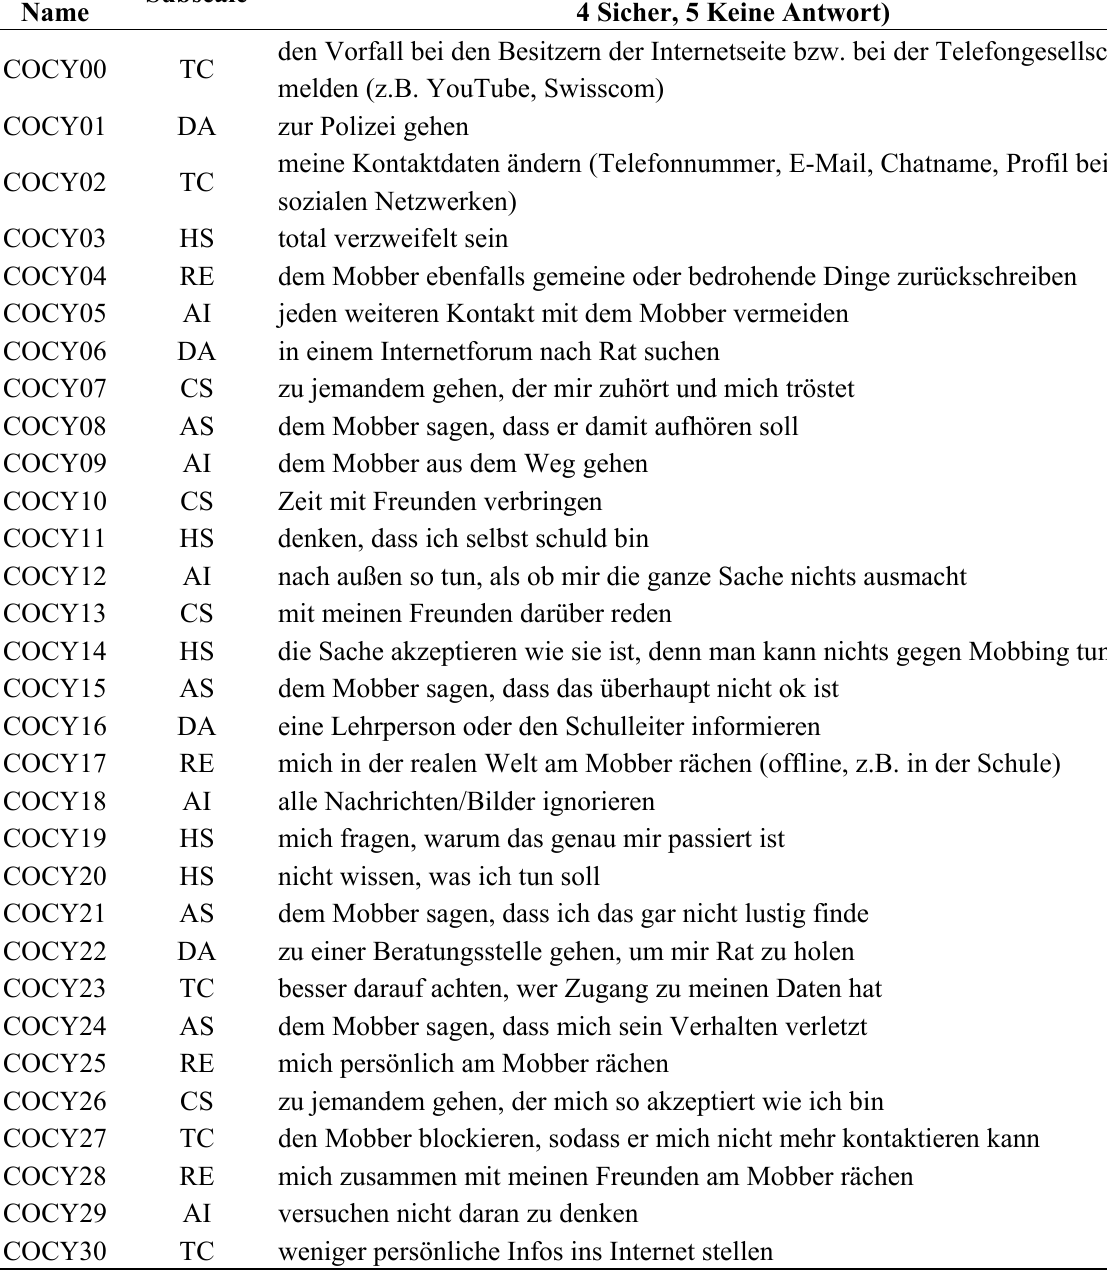
Table A2. Current German version of the Coping with Cyberbullying Questionnaire